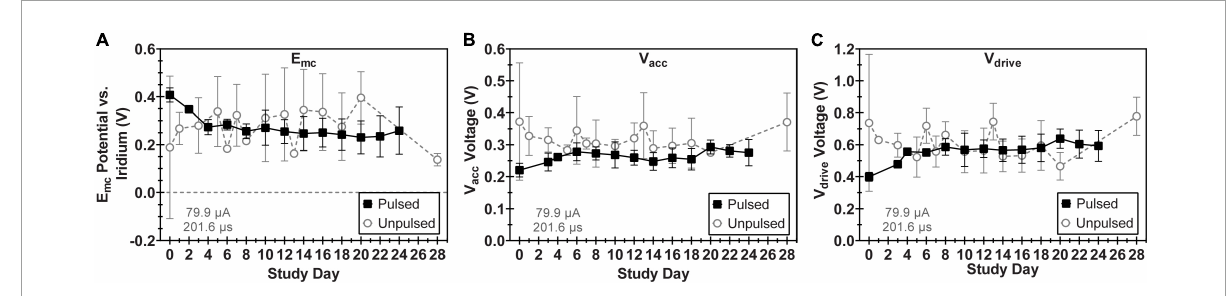
FIGURE5 Comparison of voltage transient parameters for WFMA electrodes that were pulsed versus unpulsed throughout the 24-day study in LP-PBS. (A) Cathodic polarization potential (E mc ), (B) access voltage (V acc ), and (C) driving voltage (V drive ). For the pulsed group, pulsing over a 24-day period was equivalent to 6.22 C of charge injection. Voltage transients were recorded in response to 79.9 µ A, 201.6 µ s pulses at 200